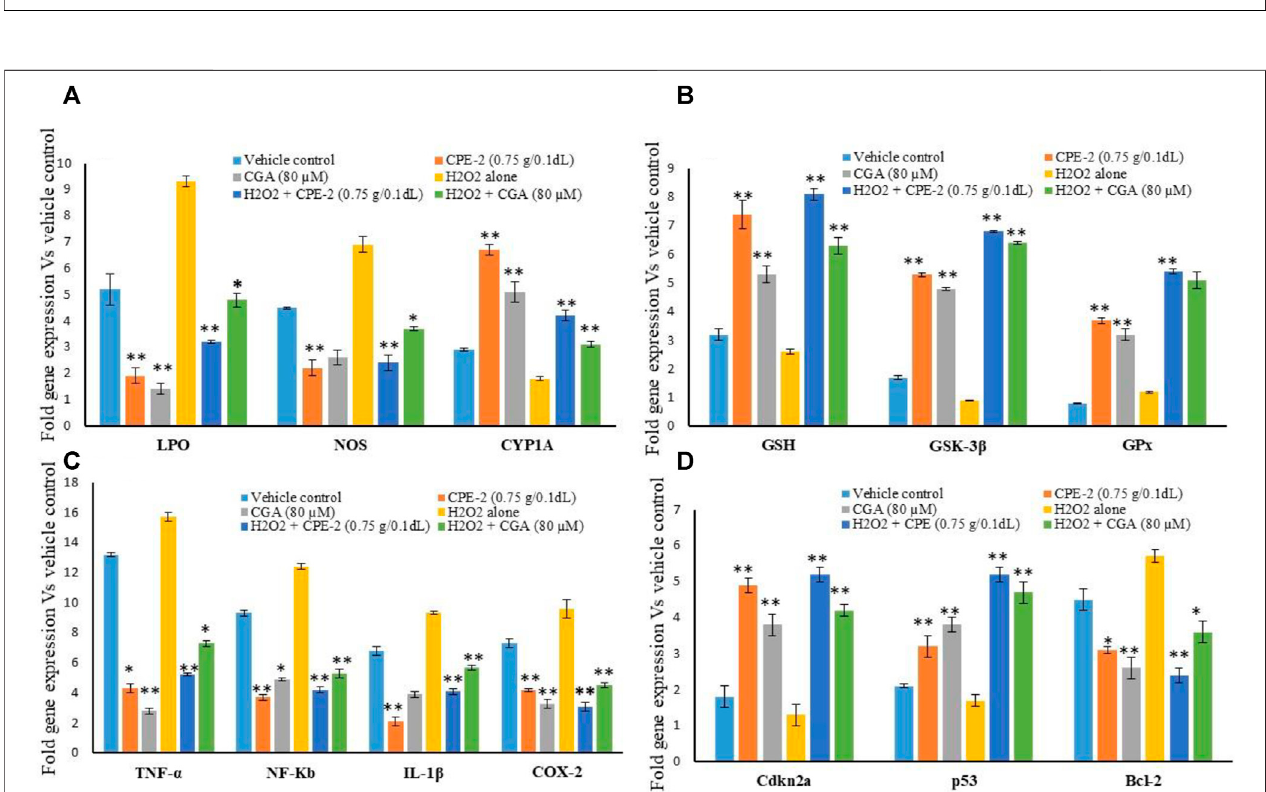
FIGURE 6 | Analysis of mitochondrial membrane potential using JC-1 staining for vehicle control and CPEs – treated hMSCs after 48 h. All the images were captured with × 20 magni fi cation (CPE-1 (cid:1) 0.5 g, CPE-2 (cid:1) 0.75 g, CPE-3 (cid:1) 1 g, and CPE-4 (cid:1) 1.25 g).